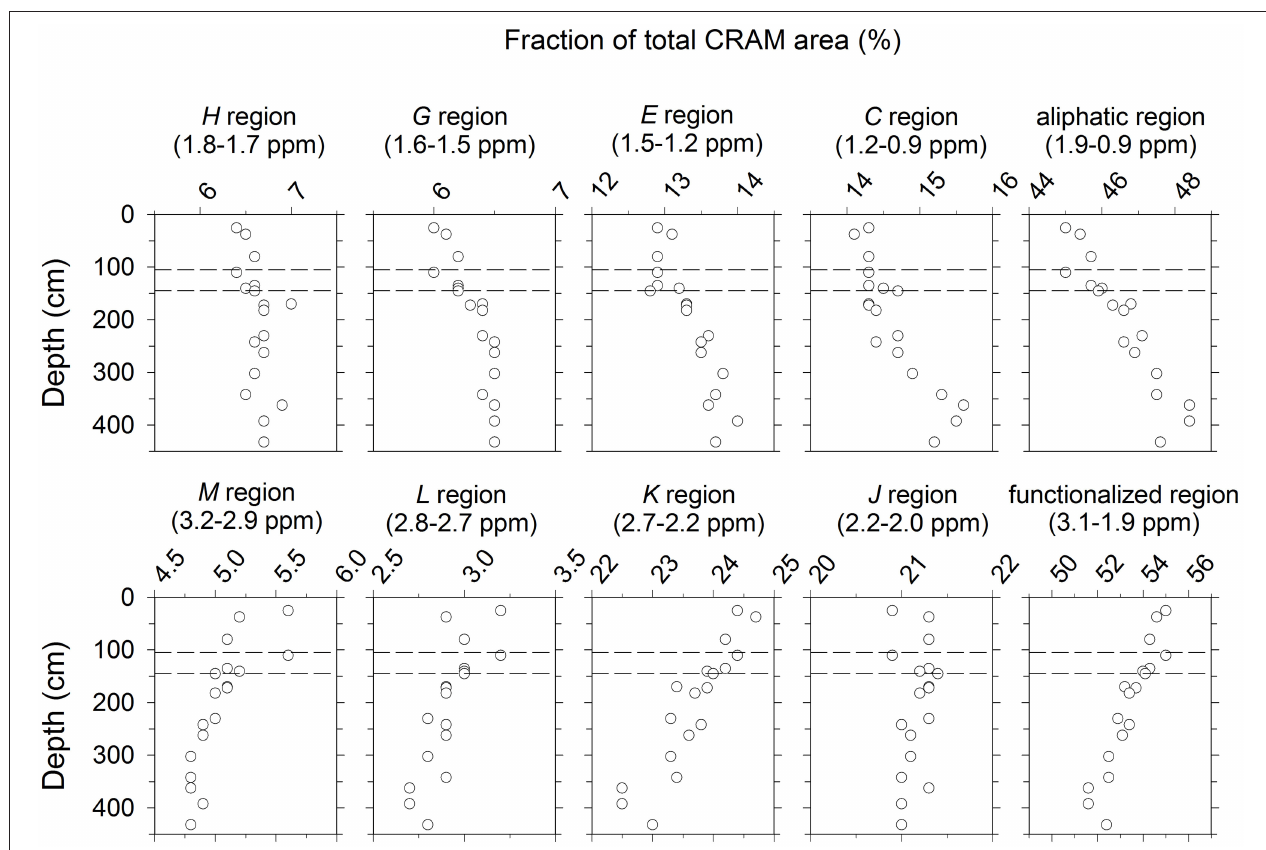
FIGURE 7 | (Left) 4 columns (8 panels): Fraction of CRAM protons that resonated in δ H ranges corresponding to peaks and bands defined in Table 2 . The sum of these sections accounted for ∼ 94% of the total CRAM envelope (see section CRAM). Far (Right) column (2 panels): Fraction of CRAM protons that resonated in the aliphatic and functionalized δ H ranges as defined in Table 1